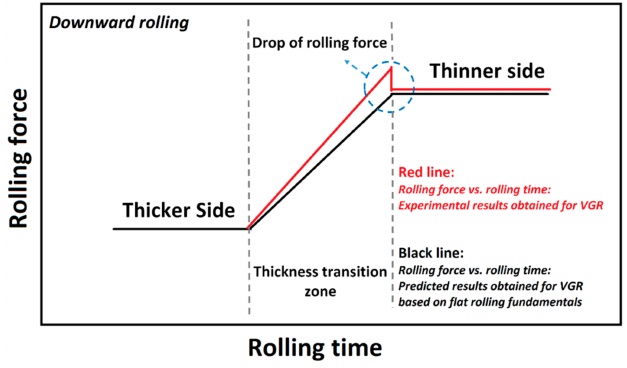
Figure 7. Schematic representation of variations of rolling force vs. rolling time during downward rolling.